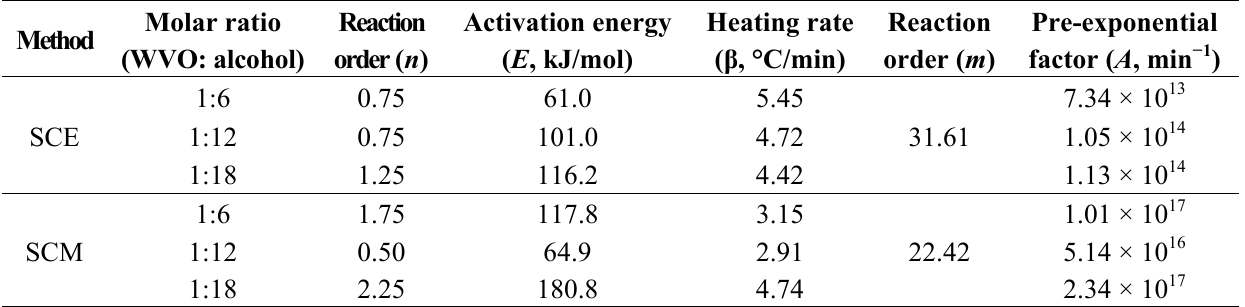
Table 2. Summary of the kinetic parameters obtained from this work.